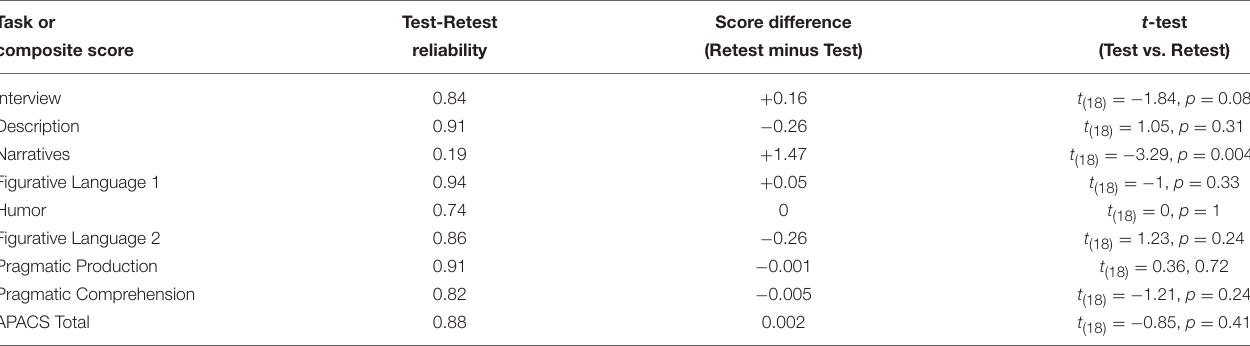
TABLE 3 | Test-Retest reliability and practice effect of APACS.